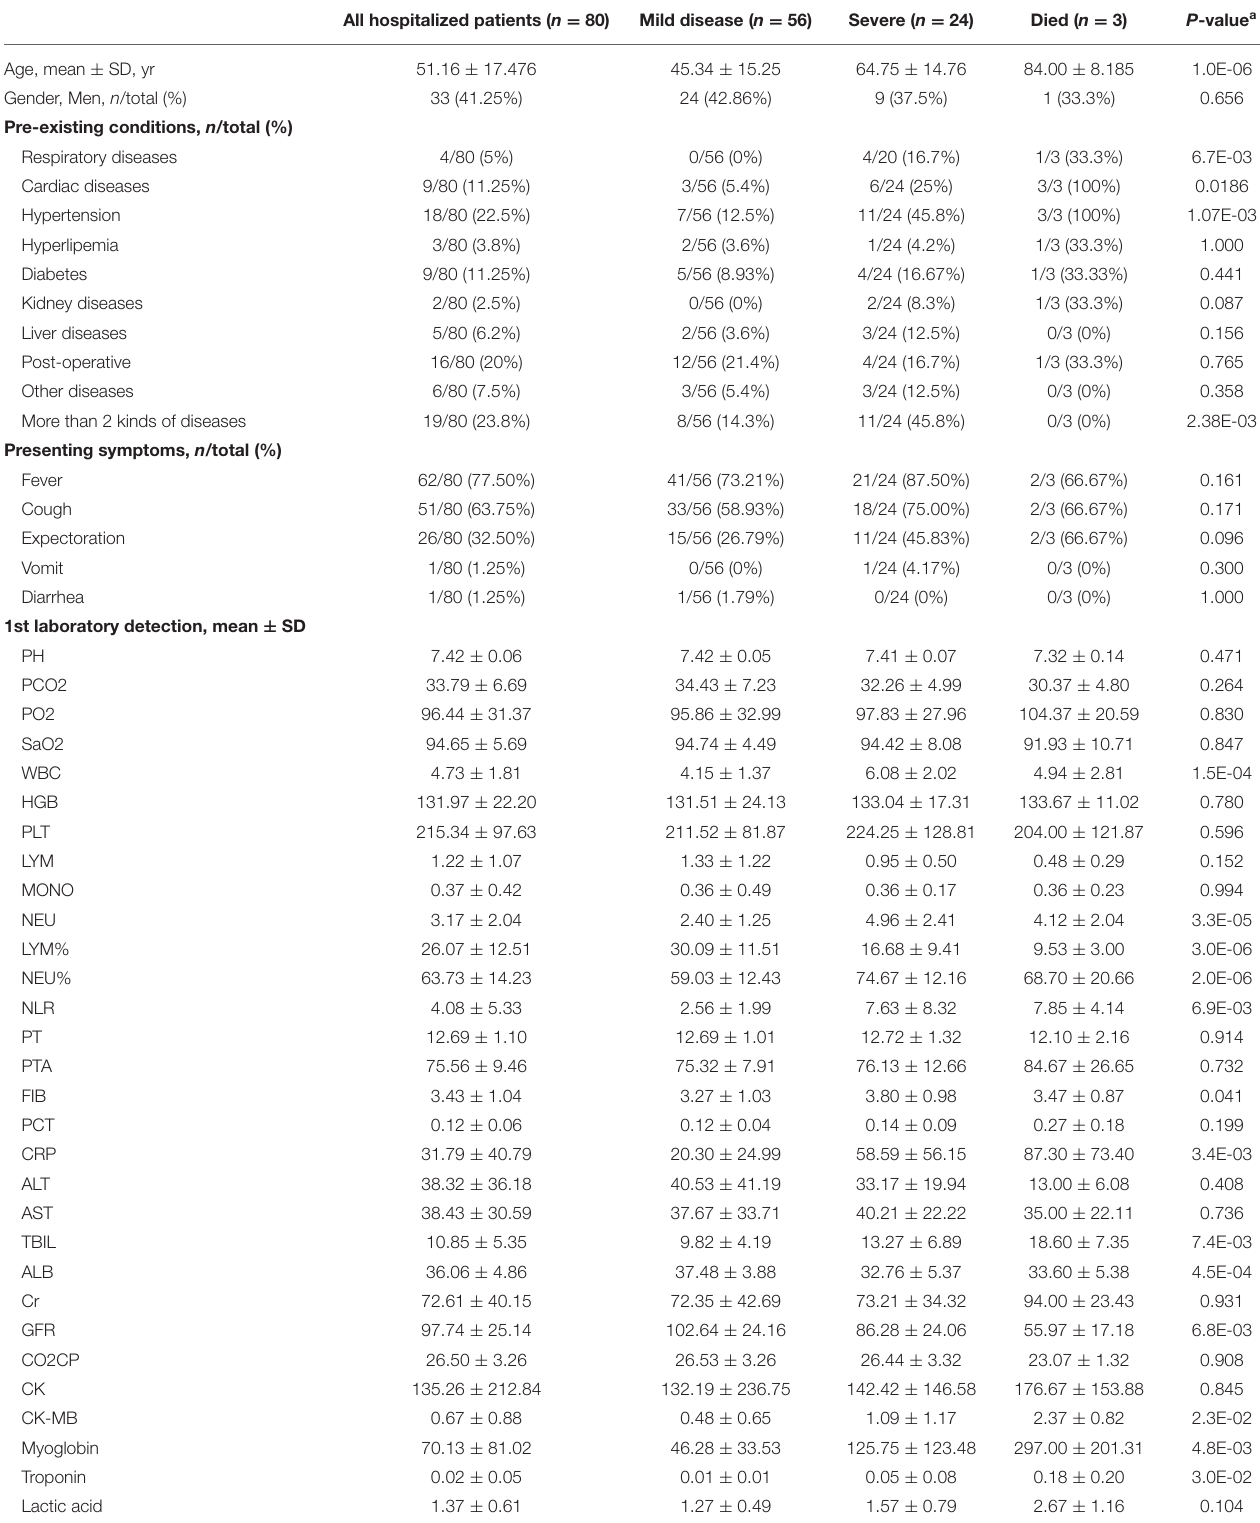
TABLE 1 | Patient demographics and clinical